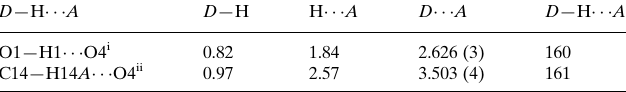
Hydrogen-bond geometry (A˚ , (cid:3)